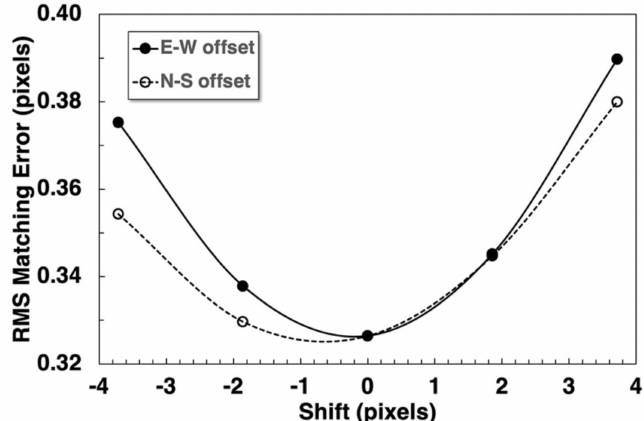
Figure 14. RMS error (expressed as matching error ρ in pixels) as a function of small offsets of the HRSC USGS DTM relative to the best alignment to the reference DTM estimated by using pc_align . Shifts are scaled to the stereo channel image pixels, consistent with our presentation of normalized resolution and error. Measurements (symbols) were made by shifting the DTM a whole number of posts, and have been connected by smooth